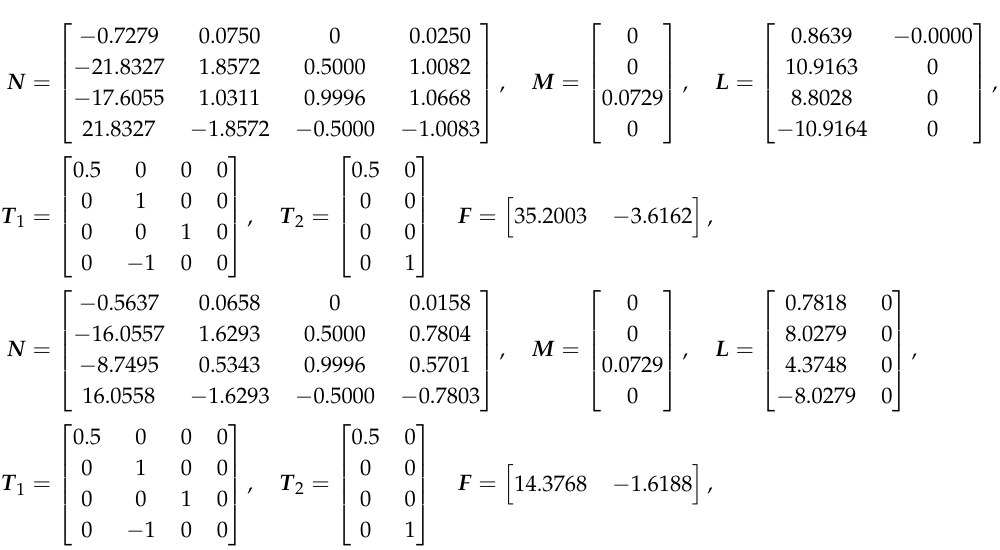
( z ) G e ∞ < µ 1 , f w 1 (cid:107) (cid:107)